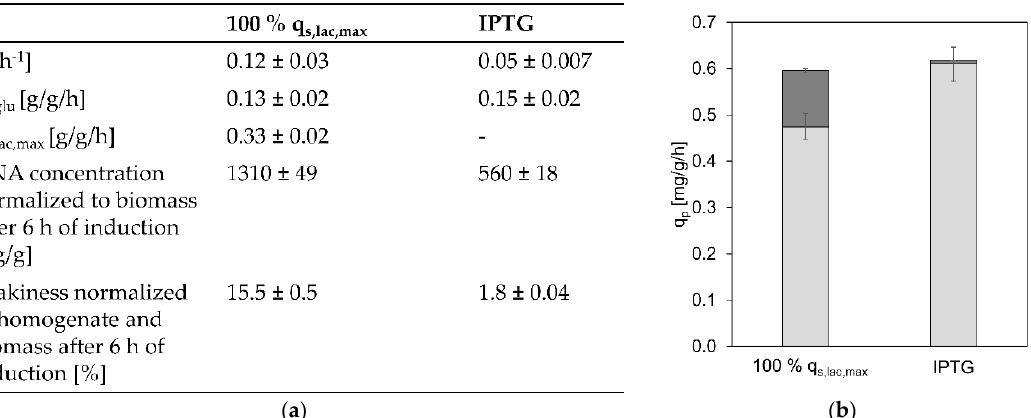
Figure 5. Physiology, leakiness, lysis, and productivity when inducing FabZ production by lactose or IPTG. ( a ) Comparison of physiological data as well as cell lysis and leakiness of the lactose induction cultivation at which the highest q p was reached and an IPTG-induced cultivation conducted at the same q s,glu ; ( b ) specific overall, intracellular (light grey), and extracellular (dark grey) product formation rates of the lactose-induced cultivation at which the highest q p was reached and an IPTG-induced cultivation conducted at the same q s,glu .